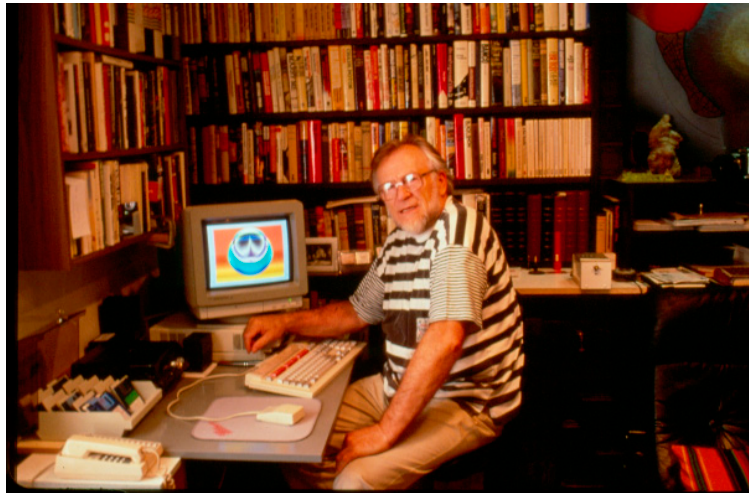
Figure 1. Ostoja in his studio with his Acorn Archimedes microcomputer, date unknown. Published with permission. Image courtesy of the State Library of South Australia. SLSA: PRG919/22/42.